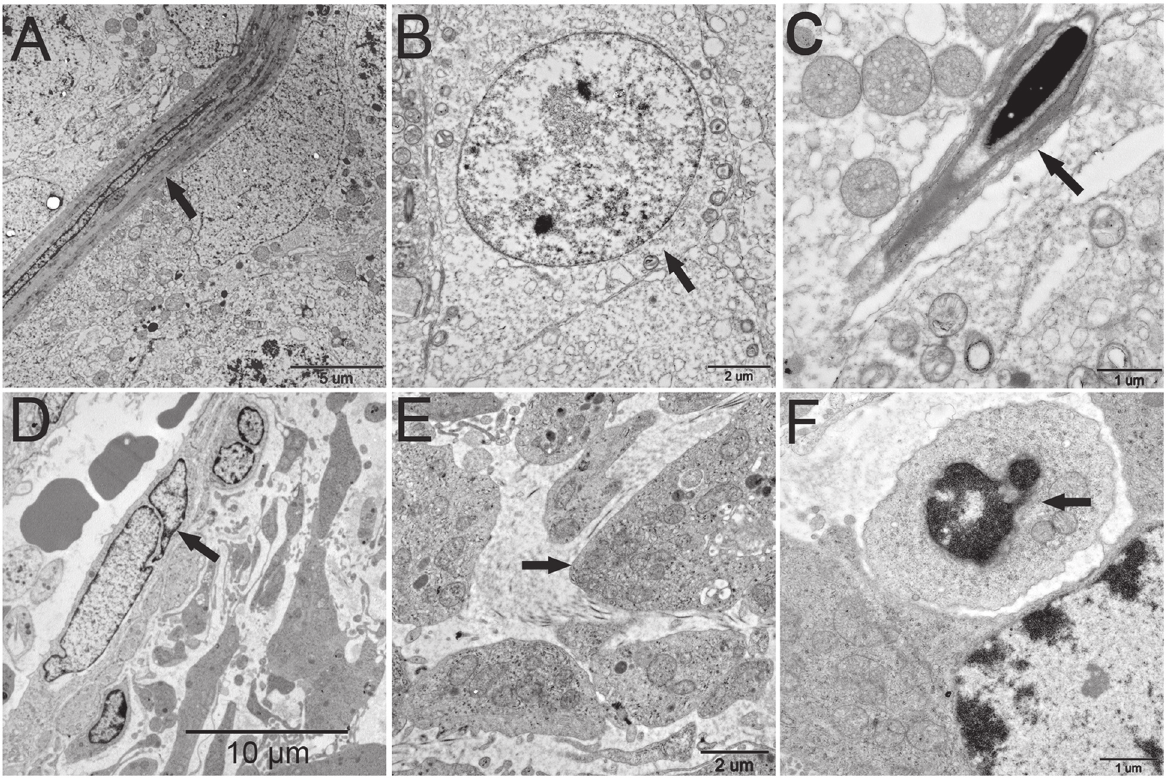
Figure 2. Electron micrographs of testis tissue from the control and experimental groups. A , B , C , Control groups showed that the basal lamina of seminiferous tubules was intact and all stages of spermatogenic cells and spermatozoa were present in the tubules (arrow). D , E , F , In the tail suspension groups the basal lamina of seminiferous tubules was rough and germinal cell loss and seriously necrotic tubules were observed